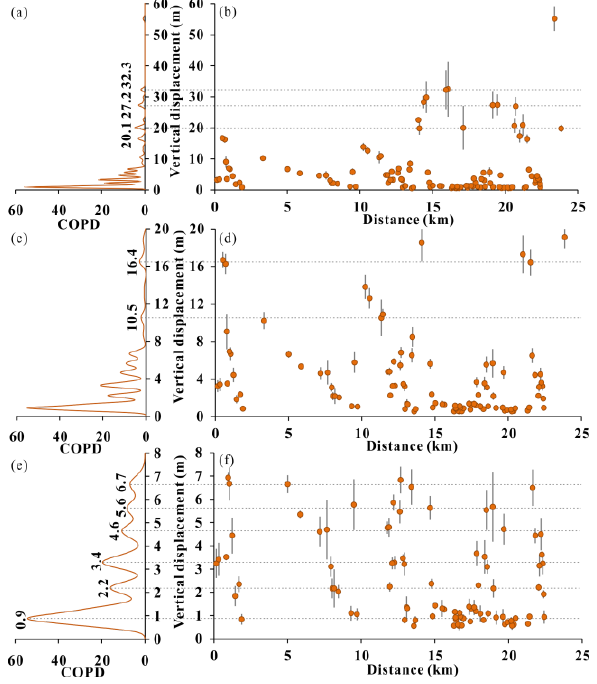
Figure 5. Strike slip on the middle segment of the West Helanshan Fault. (a), (c), and (e) represent the cumulative offset probability density (COPD) plot of the strike slip in the range of 0~120 m, 0~60 m, and 0~25 m respectively. While (b), (d), and (f) denote the distribution of the strike slip along the fault strike in the range of 0~120 m, 0~60 m, and 0~25 m